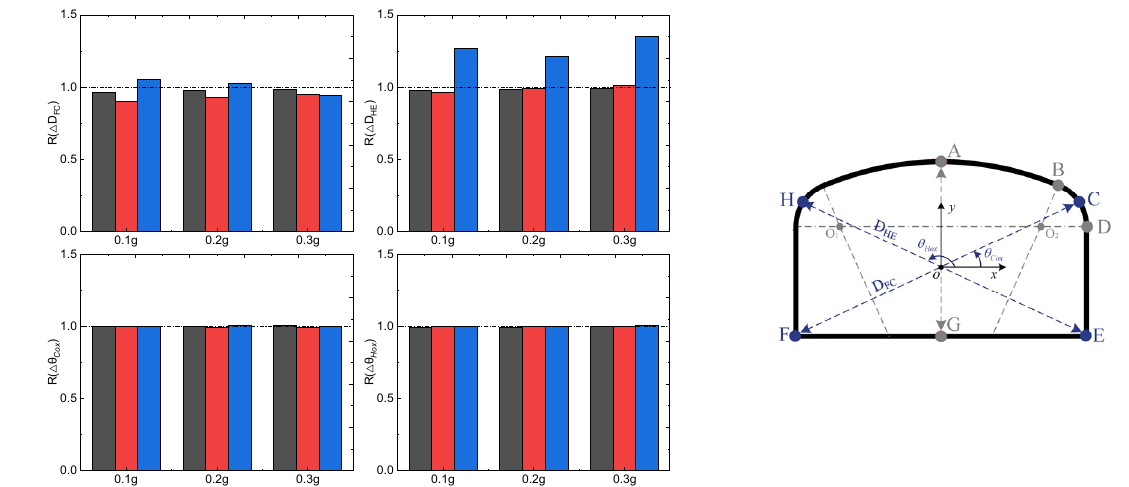
Figure 11. The response ratios of the oblique reference line CF and the line HE, and the angle θ .